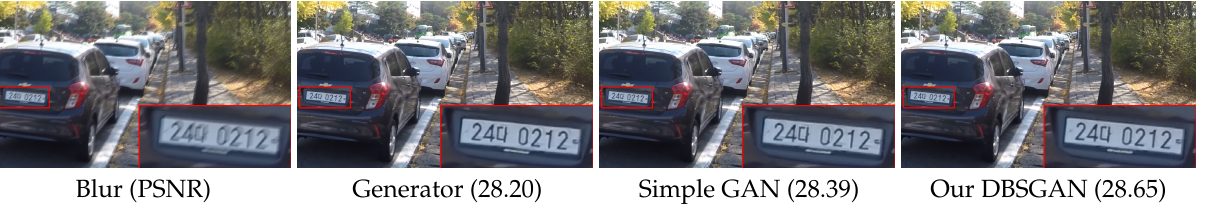
Figure 3. Visual comparisons of different components of DBSGAN on an example blurry image. Quantitative metric PSNR are reported below each